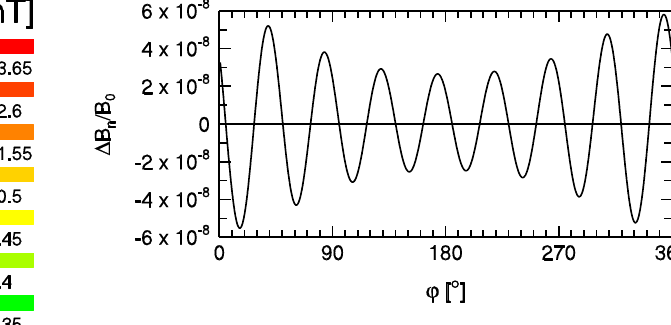
Fig. 4. Difference of B n components at the CME shock.